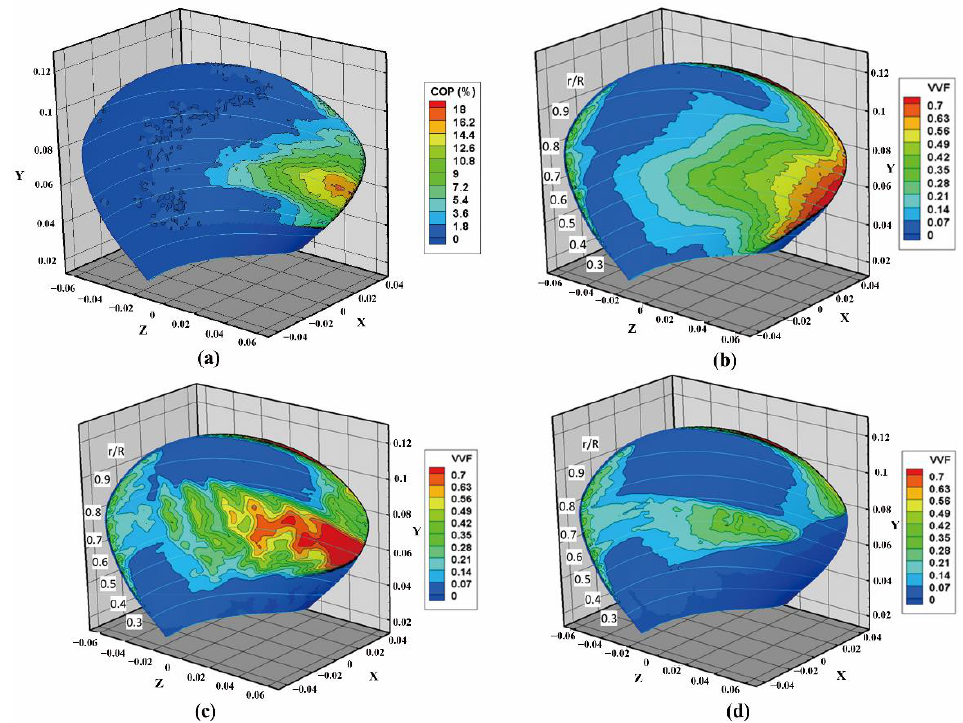
Figure 8. Distribution contours of propeller blades: ( a ) experimental COP and numerical VVFs simulated with cavitation models of ( b ) FCM, ( c ) Z-G-B, and ( d ) S – S by default values for tunable parameters.